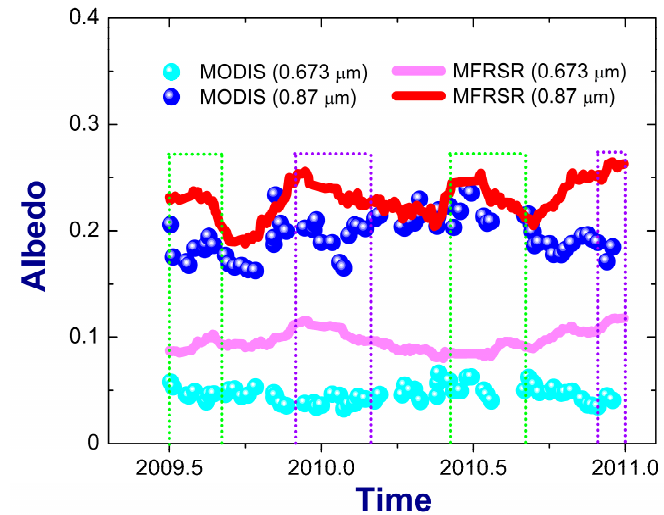
Figure 3. Time series of the MFRSR-retrieved areal-averaged surface albedo (red and magenta; boxcar averaging, 16 points) and MODIS-derived albedo for 16-day periods (blue and cyan) at two MFRSR wavelengths (0.673 and 0.87 µm) for the 19-month period of interest. Label “time” represents fractional year. Boxes with dotted green and violet lines define summer and winter, respectively.